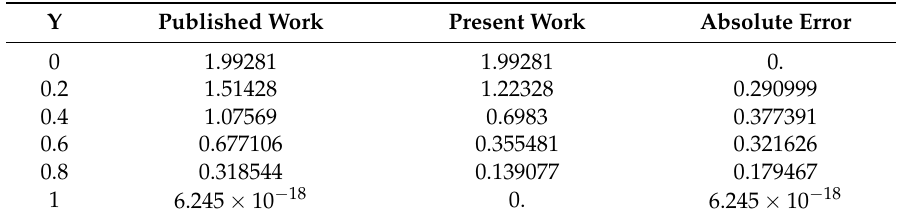
Figure 15. The comparison of ADM and OHAM methods for the temperature profile, when W m = 0.01; M = 0.1, ω = 0.02, t = 0.6, Ec = 10, Pr = 4.0, C 1 = − 0.0009350828,C 2 = − 0.0024496023, C 3 = − 2.597660913881,C 4 = 1.59769431544815. Table 1. The numerical agreement of the present work and published work [22] with absolute error,